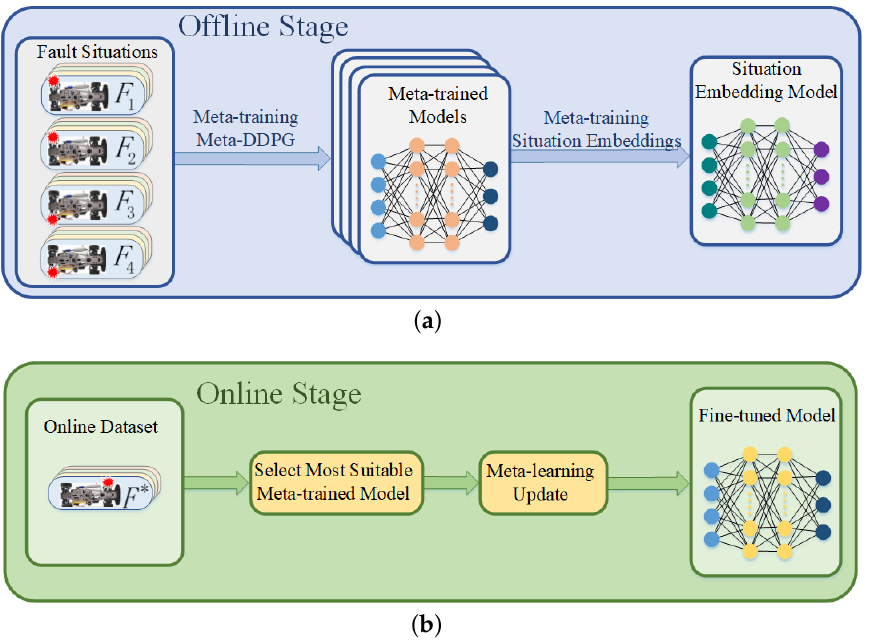
Figure 3. Framework of the meta-DDPGSE-based FTC method: ( a ) Offline stage; and ( b ) Online